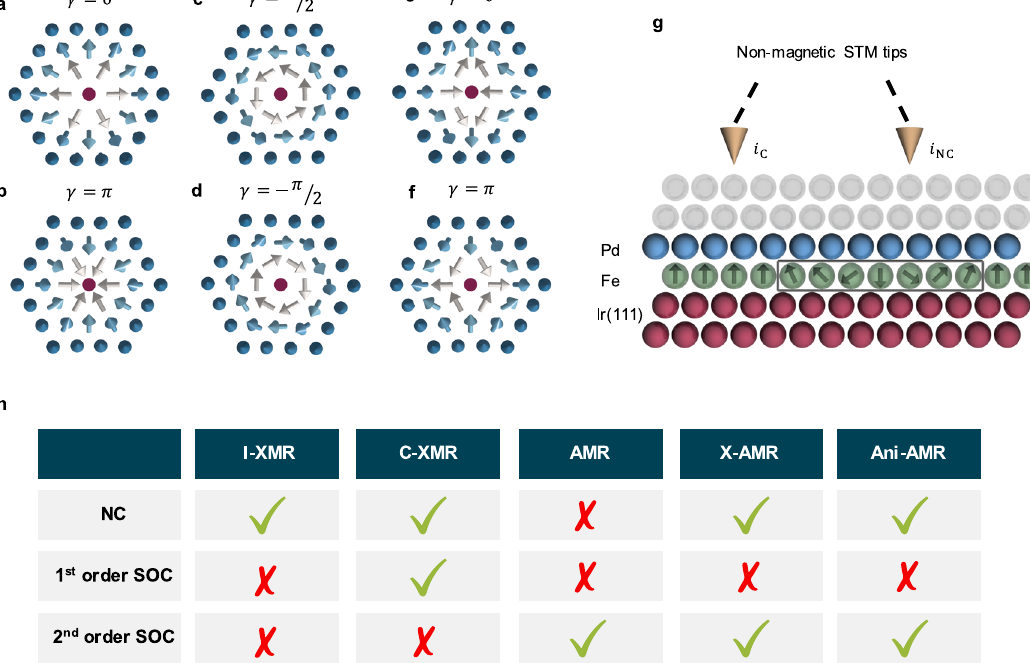
Fig. 1 Examples of various magnetic skyrmions. Néel-type skyrmion ( Q = − 1) exhibits a ( a ) counter-clockwise cycloidal spin rotation, e.g, γ = 0 or a ( b ) clockwise cycloidal spin rotation, e.g, γ = π . The Bloch skyrmion exhibits a helical spin rotation with helicity a ( c ) γ = π /2 or ( d ) γ = − π /2. The antiskyrmion ( Q = 1) with helicity ( e ) γ = 0 and ( f ) γ = π . g Illustrative STS experiment detecting the electronic signals emanating from either a magnetic skyrmion or the ferromagnetic background. The sample consists of fcc-Pd (blue spheres) atop an Fe overlayer (green spheres) on single-crystal fcc-Ir(111) bulk substrate (red spheres). The tip probes the local density of states (LDOS) two vacuum layers (gray spheres) away from Pd. h Classi fi cation of the different unveiled magnetoresistances as function of triggering mechanisms: non-collinear (NC) magnetism, 1st and 2nd order